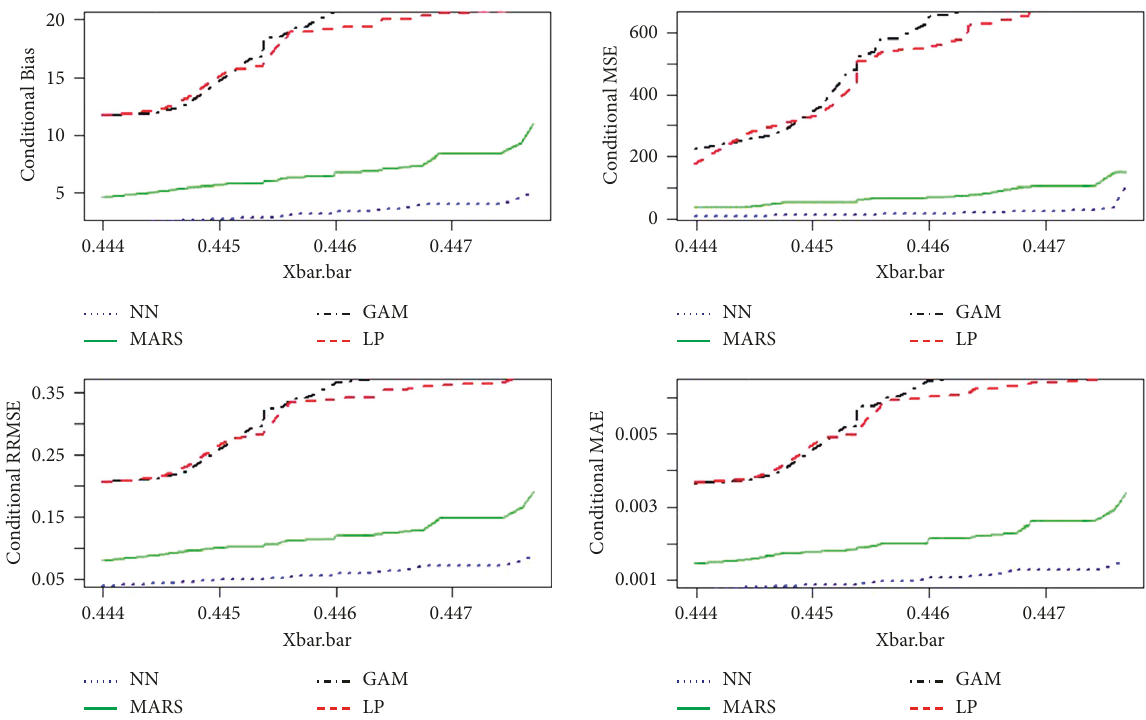
Figure 2: CB, CMSE, CRMSE, and CMAE based on a two-dimensional quadratic